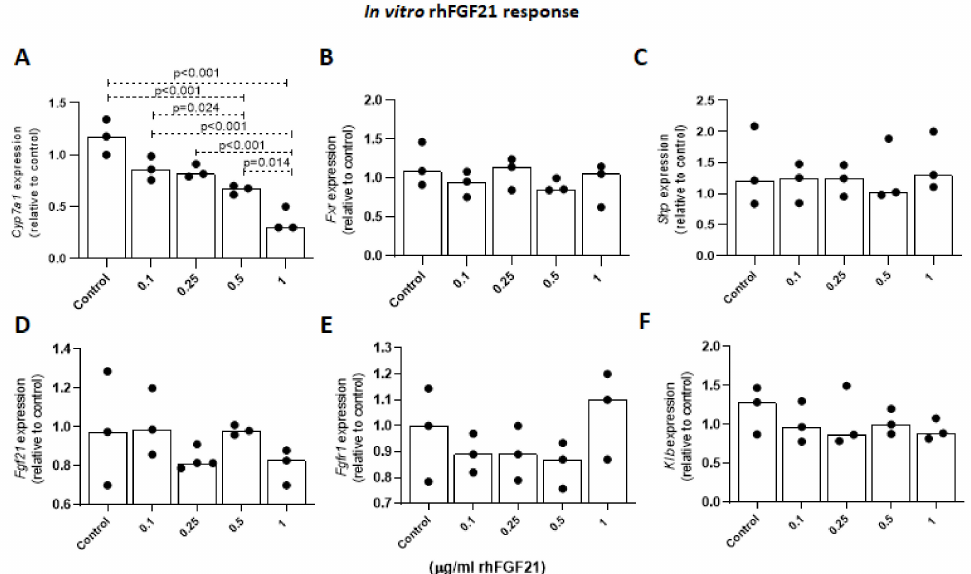
Figure 7. The effects of rhFGF21 ( µ g/mL) on primary mouse hepatocytes. Transcriptional levels of Cyp7a1 ( A ), Fxr ( B ), Shp ( C ), Fgf21 ( D ), Fgfr1 ( E ), and Klb ( F ) genes in primary mouse hepatocytes not treated with rhFGF21 (control) or cells treated with rhFG21 at different doses (0.1–1 µ g/mL) for 24 h. All data represent x-fold change as compared to control hepatocytes ( n = 3 independent primary mouse hepatocyte cultures). p < 0.05 was considered